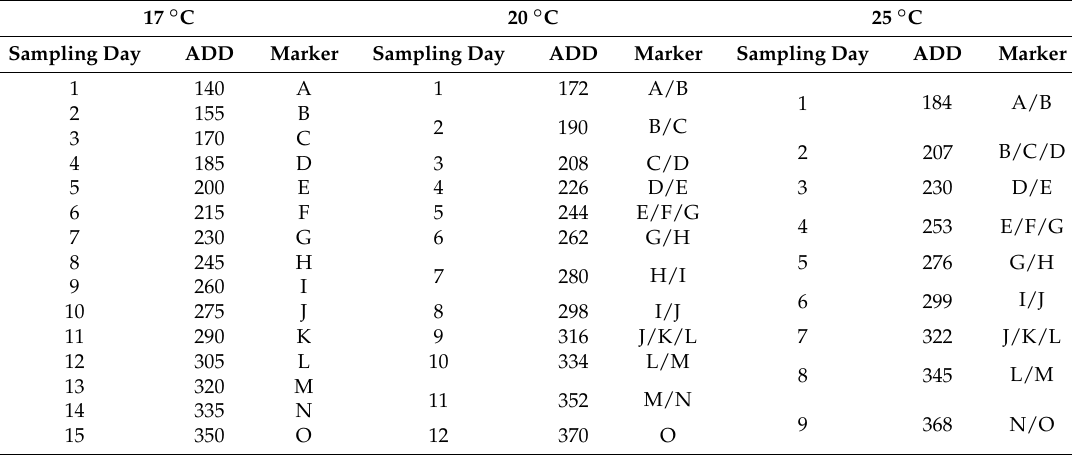
Table 2. Sampling days assigned to the progress of metamorphosis in ADD and the corresponding gene expression marker for breeding at 17, 20 and 25 ◦ C. Each of those 15 development days represents a developmental